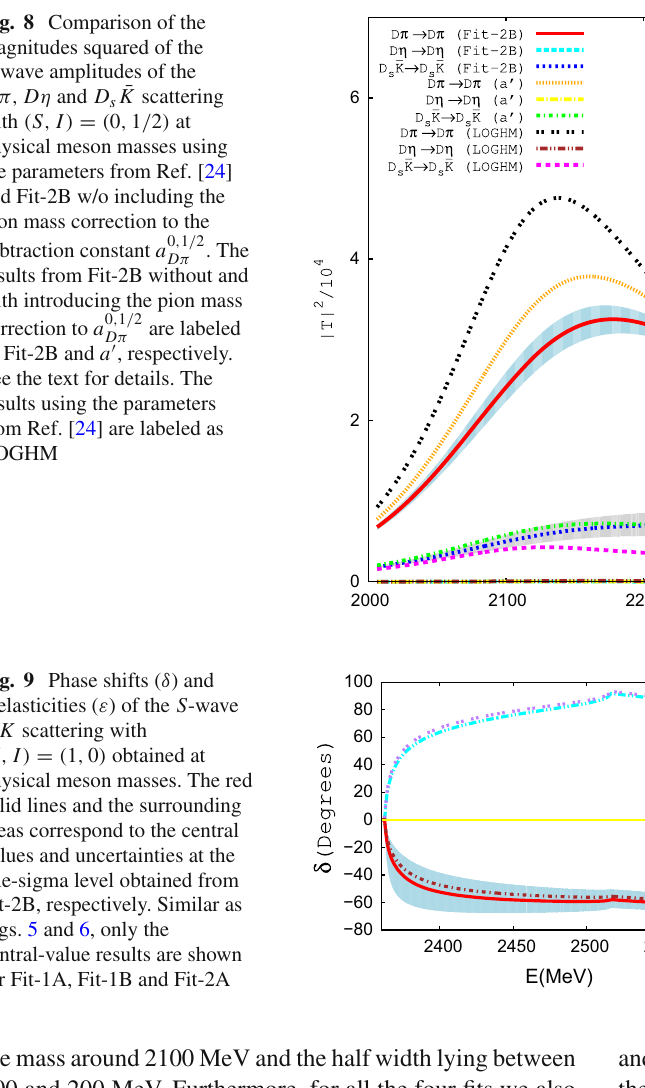
Fig. 8 Comparison of the magnitudes squared of the S -wave amplitudes of the D π, D η and D s ¯ K scattering with ( S , I ) = ( 0 , 1 / 2 ) at physical meson masses using the parameters from Ref. [24] and Fit-2B w/o including the pion mass correction to the , 1 / 2 subtraction constant a 0 . The D π results from Fit-2B without and with introducing the pion mass , 1 / 2 correction to a 0 are labeled D π as Fit-2B and a (cid:3) , respectively. See the text for details. The results using the parameters from Ref. [24] are labeled as LOGHM